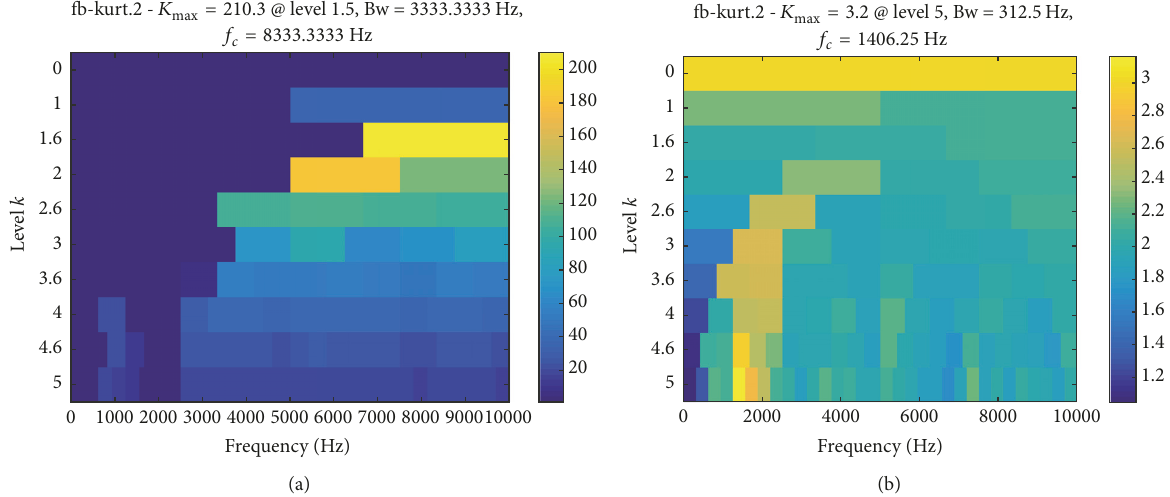
Figure 2: The kurtogram results of the signal shown in Figure 1. (a) is the result of the signal without noise. (b) is the result of the signal with additive noise, where the signal-to-noise ratio (SNR) is −